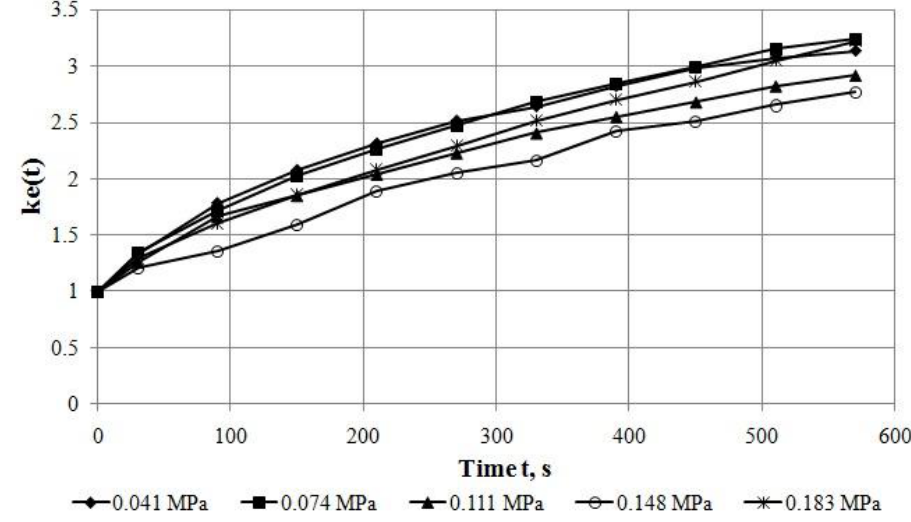
Figure 8. Isochronous creep curves of the asphalt concrete.